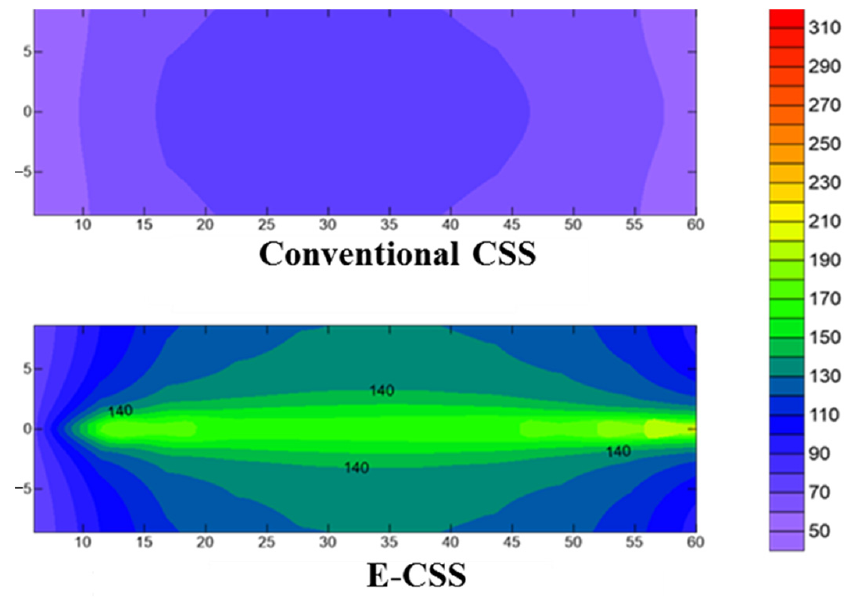
Figure 6. The comparison of the temperature field at the middle of the second cycle production phase.